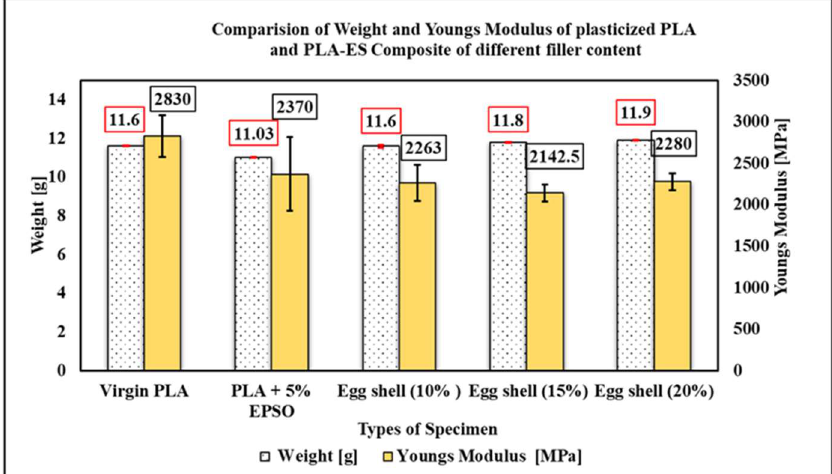
Figure 3. Tensile test result—Young’s modulus [MPa] comparison with weight [g].